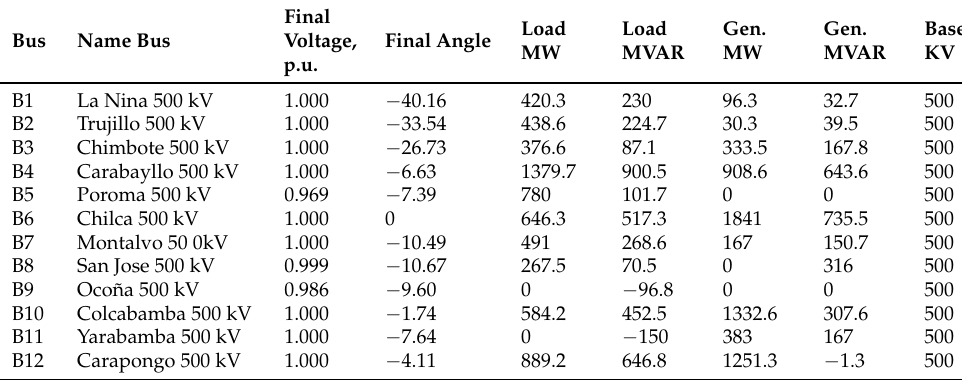
Table 3. Results of power flow execution (AC model) applied to the non-linear reduced equivalent model in 500 kV (12-bus) of the